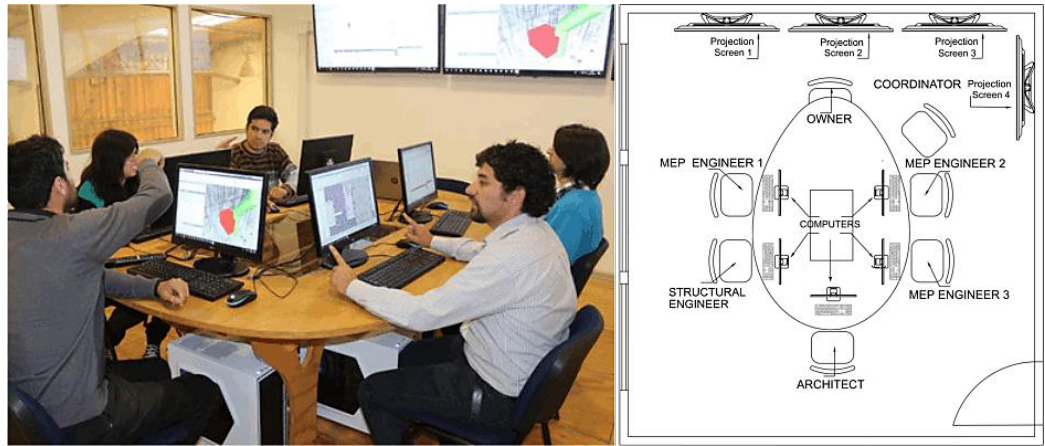
Figure 1. Layout and implementation of the collaborative work environment.